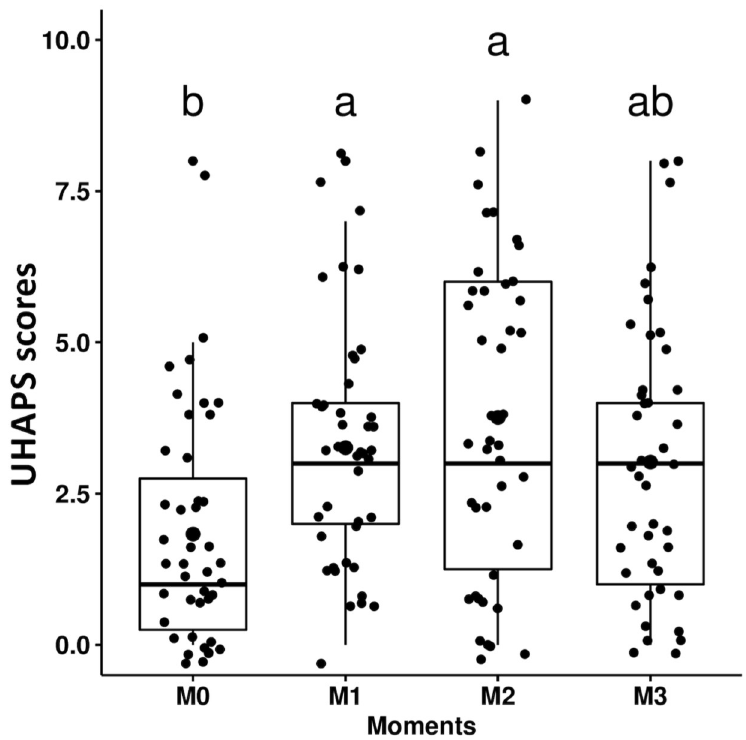
Fig 2. Box plots of the total scores of the Unesp-Botucatu horse acute pain scale (UHAPS) over time. M0 –before surgery; M1 –up to 4 hours after surgery; M2—up to 3 hours after analgesic treatment; M3–24 hours after surgery. Small letters represent statistically significant differences (a > b).